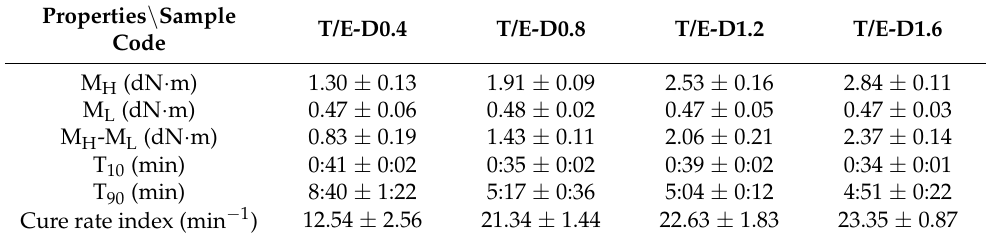
Table 1. Result of the vulcanization characteristic curve.